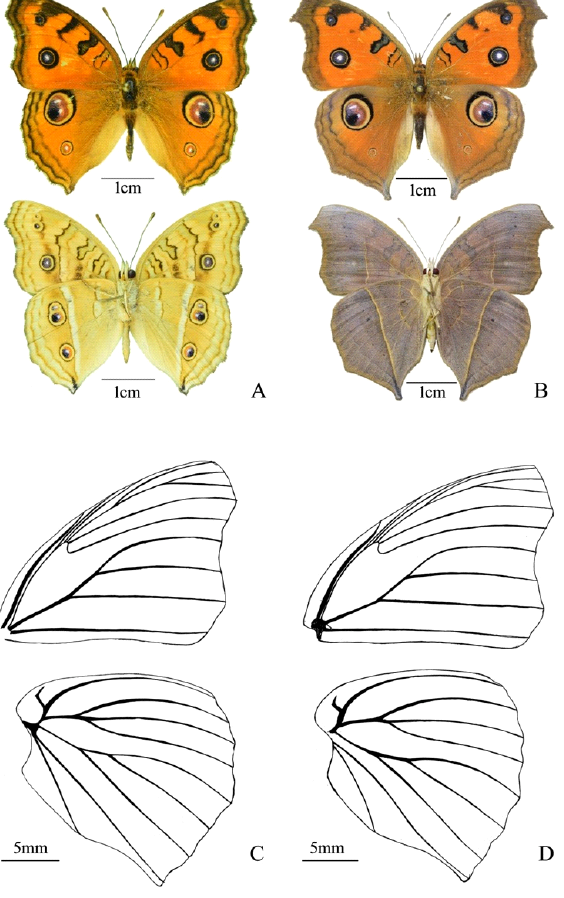
Figure 10. Junonia almana (Linnaeus, 1758) A - male (wet season form); B - female (dry season form); C - wing venation (male); D - wing venation